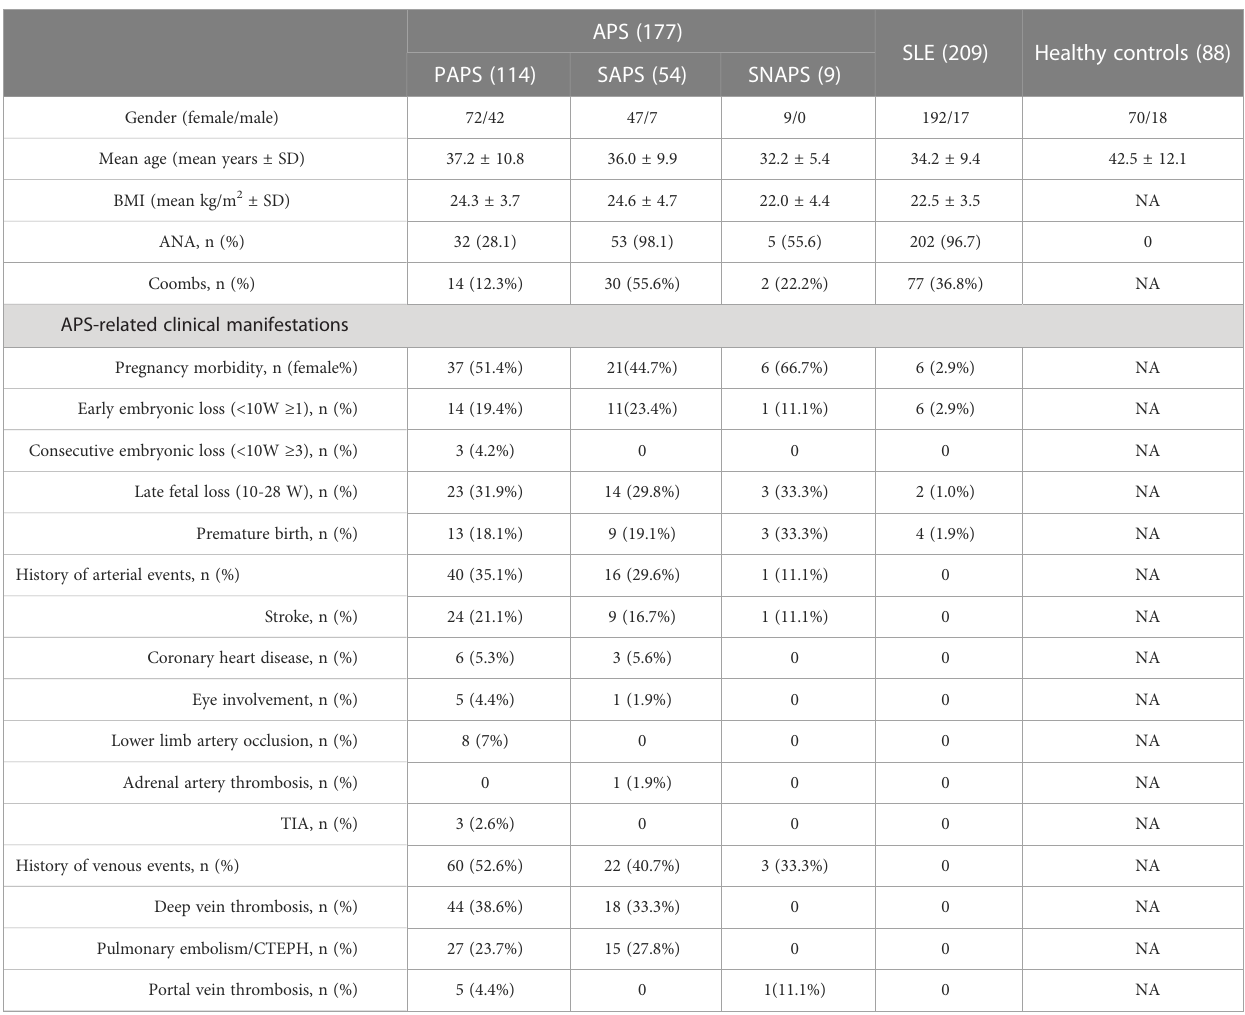
TABLE 1 Baseline information for APS, SLE, and healthy controls (n =